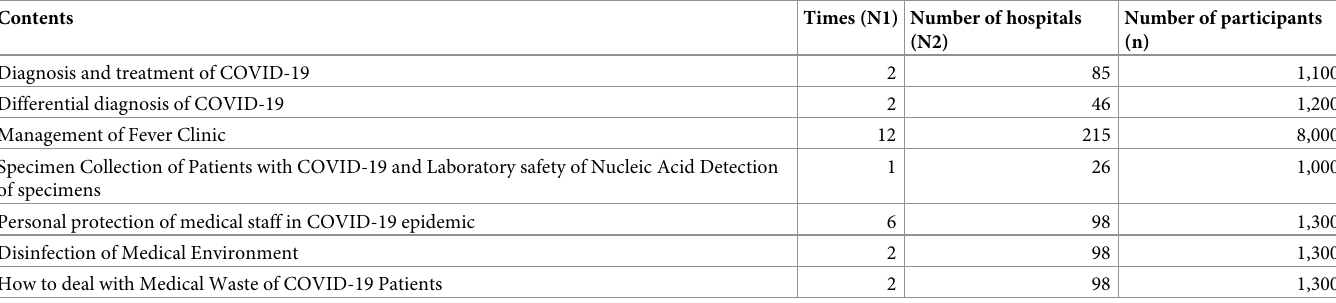
Table 4. Long-distance education related to COVID-19 (N1 = 27, N2 = 666, n = 15,200).